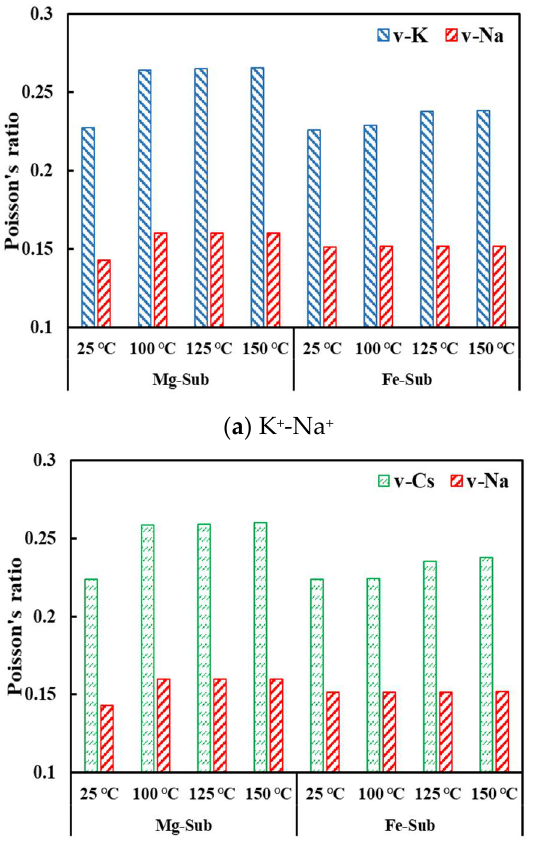
Figure 9. Elastic modulus of MMT crystals under different temperatures and inhibiting cations.